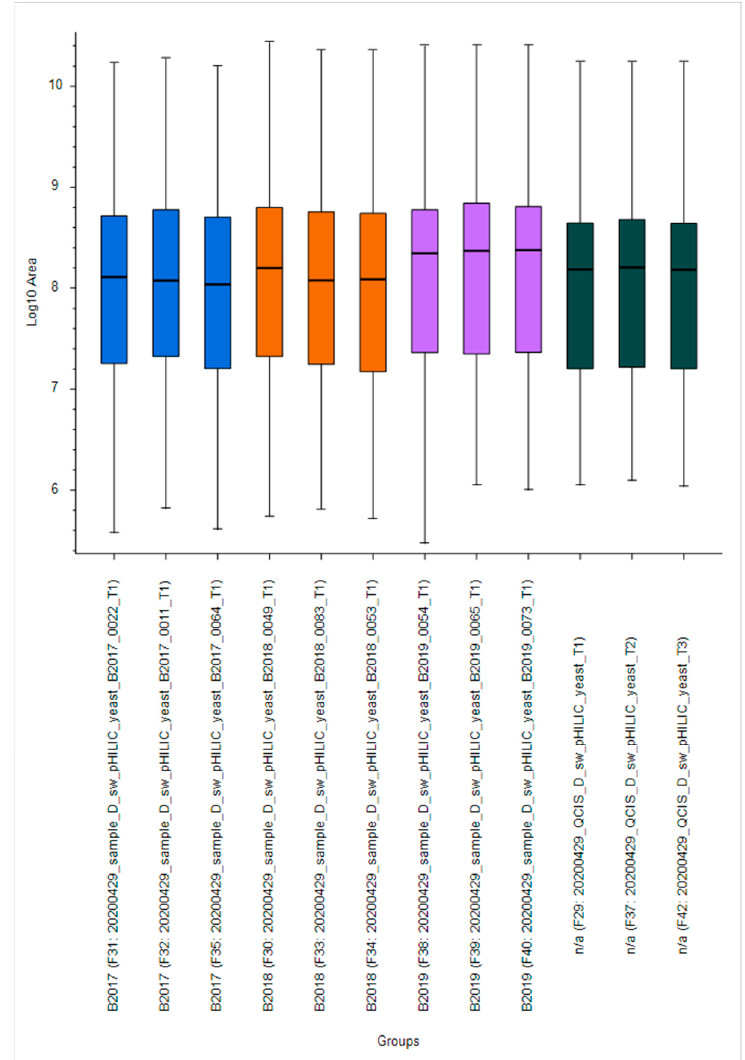
Figure A3. ( A ) Box ‐ and ‐ whisker plot of the data distribution. Each box corresponds to the annotated metabolite areas of each sample on a logarithmic scale (log 10 ) measured with RP ‐ HRMS. Ethanolic yeast extracts ( n = 3) from three different years (2017, 2018, 2019) and the mixed quality control ( n = 3) are compared. Variance depicts the broad concentration range of the metabolome. Data were analyzed using Thermo Compound Discoverer. ( B ) Box ‐ and ‐ whisker plot of the data distribution. Each box corresponds to the annotated metabolite areas of each sample on a logarithmic scale (log 10 ) measured with HILIC ‐ HRMS. Ethanolic yeast extracts ( n = 3) from three different years (2017, 2018, 2019) and the mixed quality control ( n = 3) are compared. Variance depicts the broad concentration range of the metabolome. Data were analyzed using Thermo Compound Discoverer.